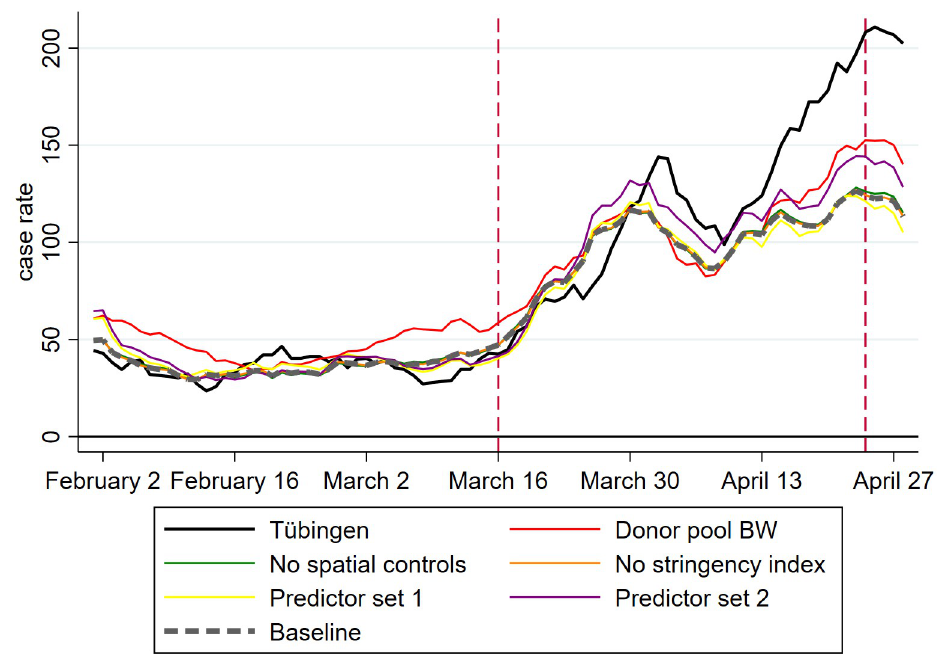
Fig 2. Seven-day case rates for alternative predictor sets and donor